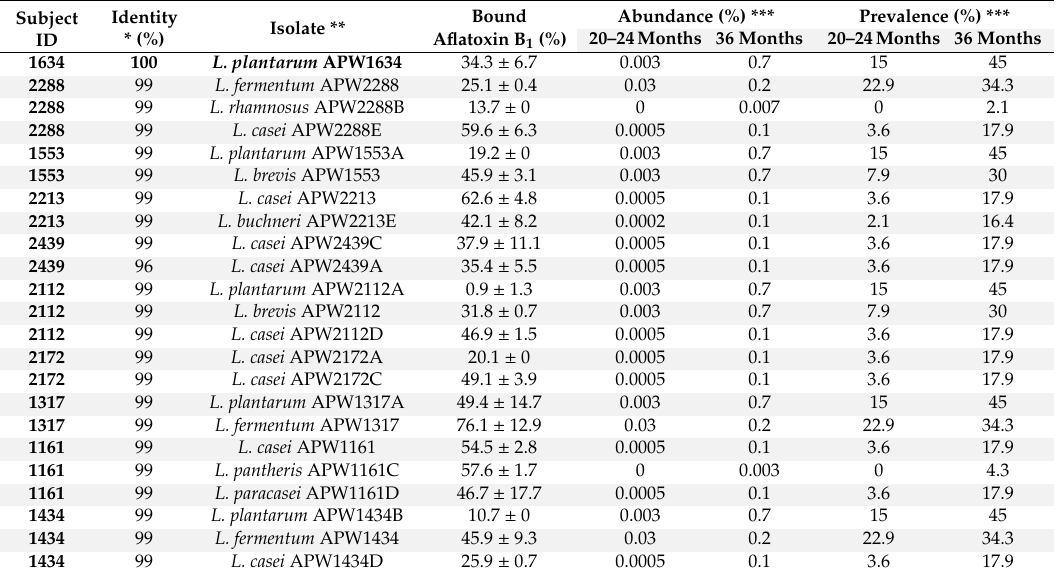
Table 2. Lactobacillus species isolated from children of Kabale and Kisoro, southwestern Uganda, aged 54–60 months with their aflatoxin B 1 binding properties and matches in the gut microbiota at 20–24 and at 36 months presented as percentage abundance and prevalence. Values for bound aflatoxin B 1 (%) are means ± standard deviations of three independent experiments at a cell concentration of 10 8 cfu mL − 1